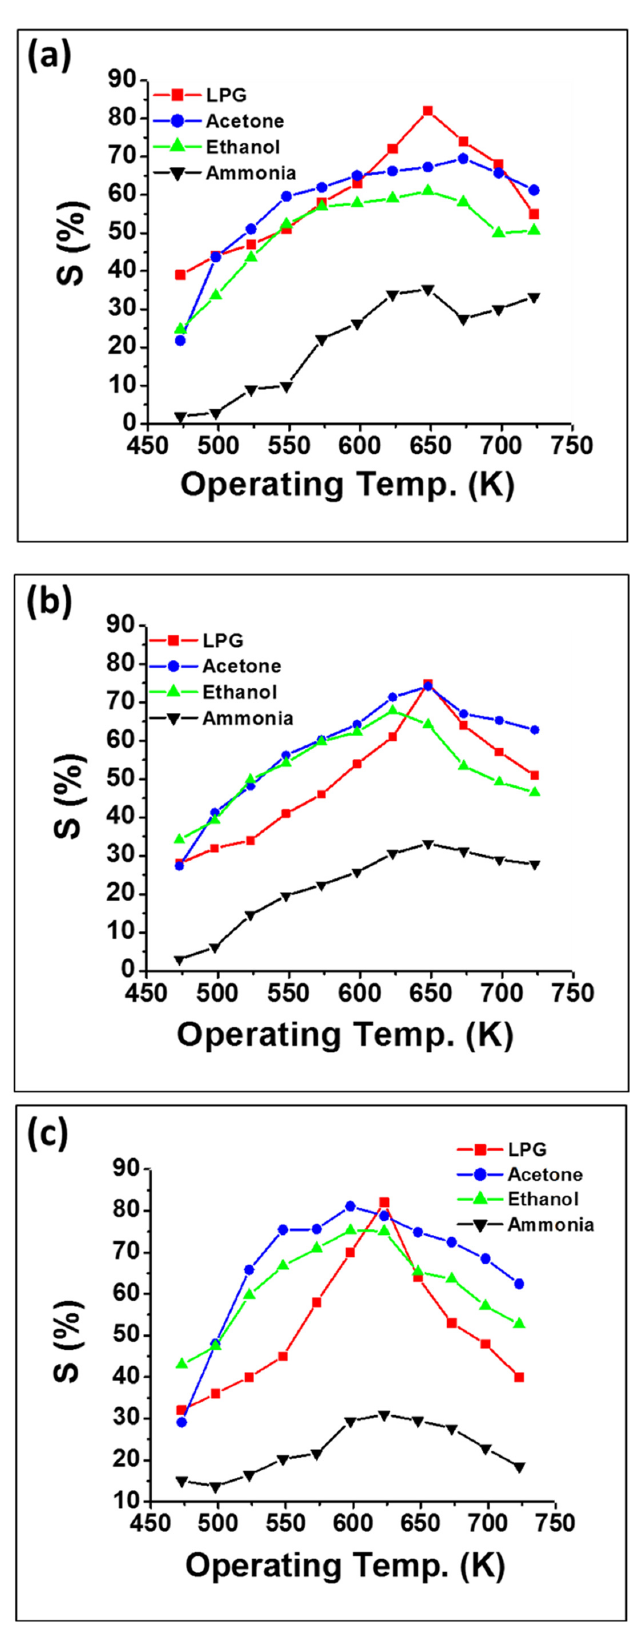
Figure 5. Gas response as a function of operating temperature for MgFe 2-x O 4- δ ferrite, ( a ) x = 0, ( b ) x = 0.05, and ( c ) x = 0.1, respectively.